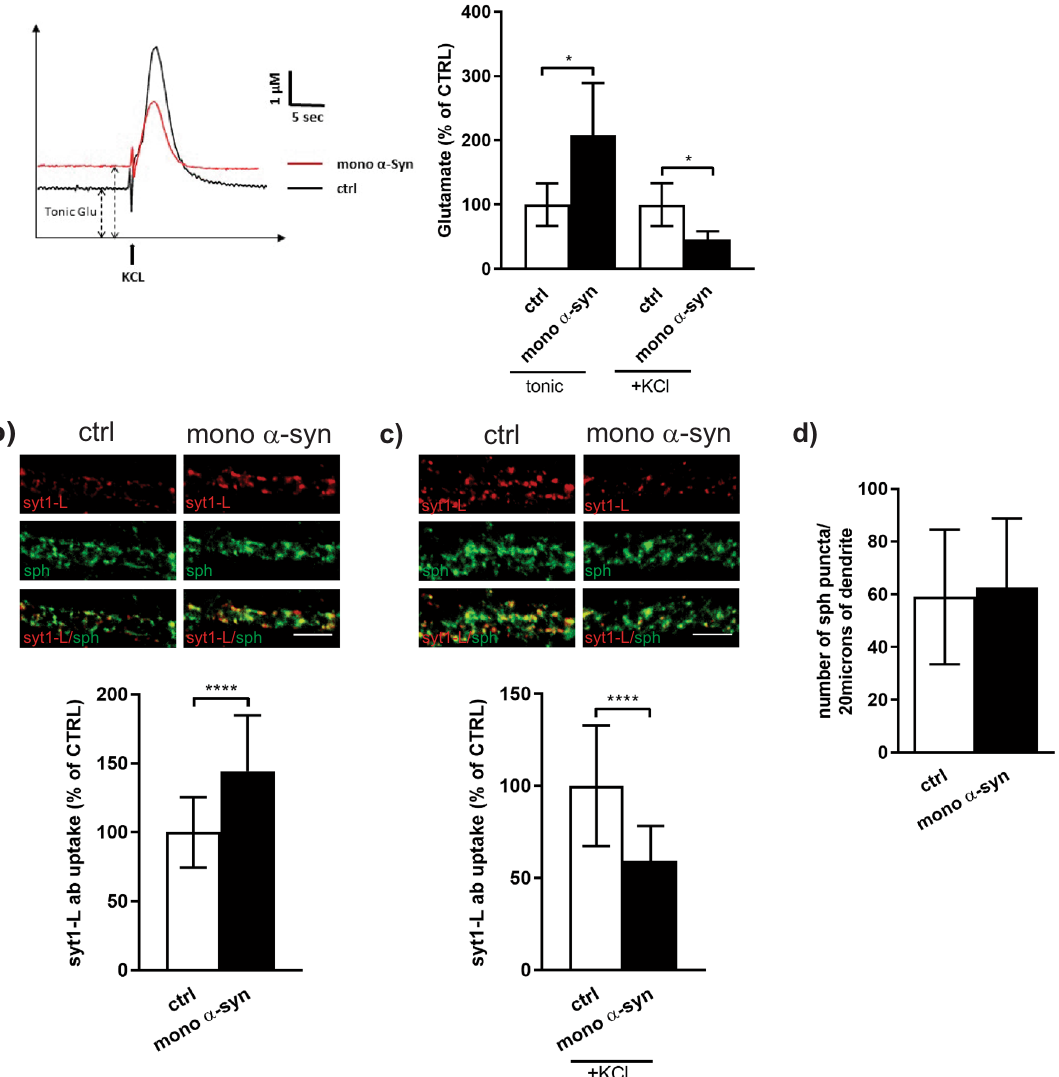
Fig. 1 Exogenous α -synuclein alters glutamate release and synaptic vesicle recycling. a Graphical traces and quanti fi cation of tonic and depolarization-evoked (KCl) glutamate release measured in the prelimbic region of prefrontal cortex in mice upon local application of saline (ctrl; N = 4 animals) or 500 nM of recombinant monomeric α -syn (mono α -syn; N = 4 animals). Statistical signi fi cance was assessed using Student ’ s t test. * p < 0.05. b Representative images and corresponding quanti fi cation of network-activity-driven syt1L-ab uptake (red) in primary cortical neurons treated with control solution (ctrl; N = 88 cells) or 500 nM mono α -syn ( N = 69 cells) for 90 min. Synaptophysin (sph; green) was used as a synaptic marker. Data are obtained from six independent experiments. Statistical signi fi cance was evaluated using Mann – Whitney U -test. **** p < 0.0001. c Representative images and corresponding quanti fi cation of KCl-depolarization-induced syt1L-ab uptake (red) in primary cortical neurons treated with control solution (ctrl; N = 43 cells) or 500 nM mono α -syn ( N = 42 cells) for 90 min. Synaptophysin (sph; green) was used as a synaptic marker. Data are obtained from four independent experiments. Statistical signi fi cance was evaluated using Mann – Whitney U -test. **** p < 0.0001. d Bar graph denotes the number of sph-positive puncta along 20 µm of proximal dendrite in control ( N = 72) and α -syn-treated cells (500 nM; 90 min; N = 59). Mann – Whitney U -test. p = 0.512. Data originate from six independent experiments. b – d All bars denote intensity values normalized to the mean intensity value in the control group ± SD per each experimental setup. All treatments were done at DIV 21 – 23. Scale bar 5